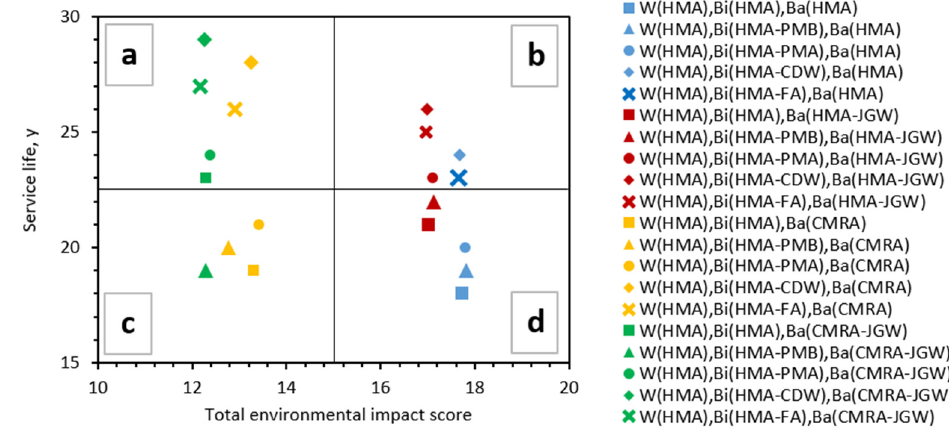
Figure 5. Total environmental impact score versus service life of each pavement configuration: Identification of the four regions of the plot ( a , b , c , and d ).